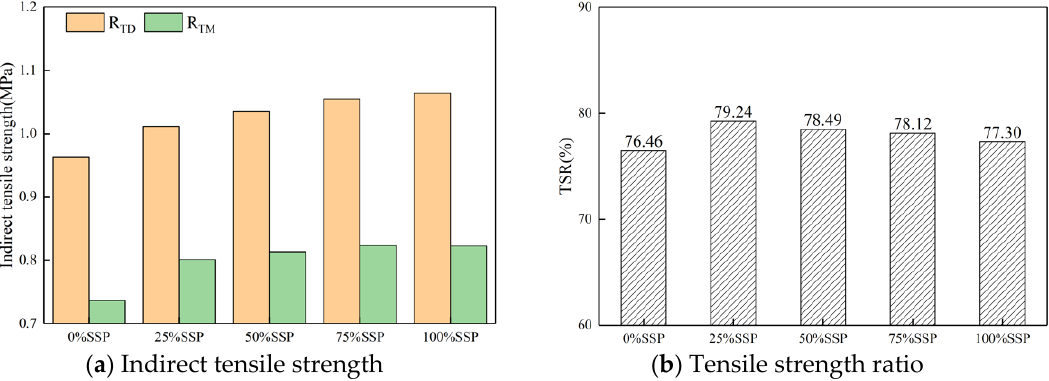
Figure 11. ITS and TSR of samples with different substitution of SSP.